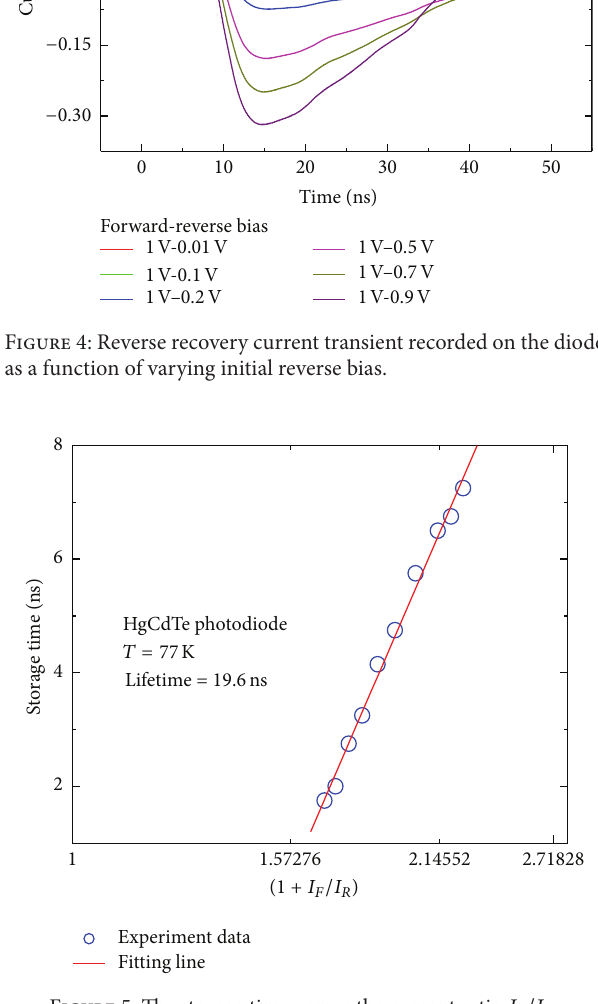
Figure 5: The storage time versus the current ratio 𝐼 𝐹 /𝐼 𝑅